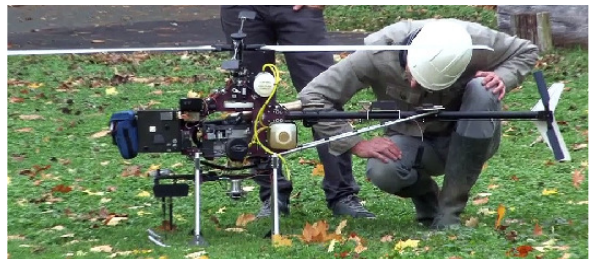
Figure 11. UAV type Copter 1B developed by Wikhydro. Source : (Website wikhydro)